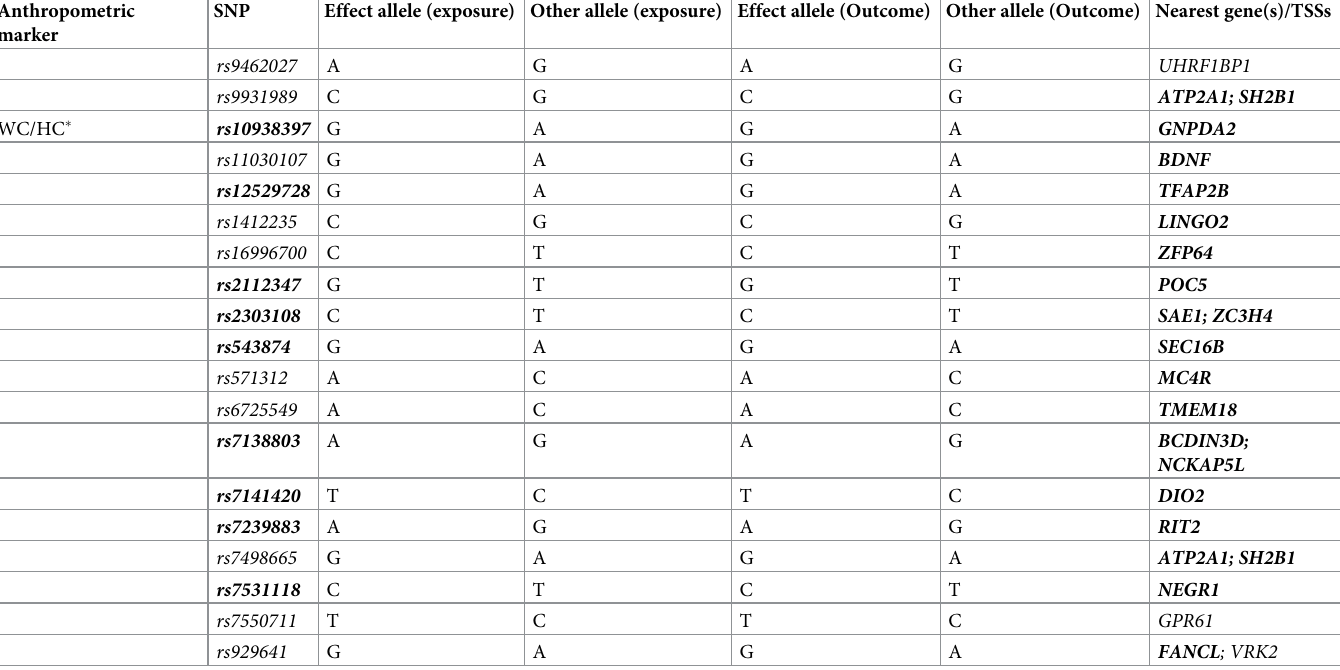
� WC and HC demonstrated the same genetic architecture (17 SNPs/21 genes) underlying their significant causal associations with polycystic ovarian syndrome. Shared/ overlapping SNPs and nearest genes/TSSs across anthropometric markers are highlighted in bold. BMI = body mass index; HC = hip circumference; WC = waist circumference.